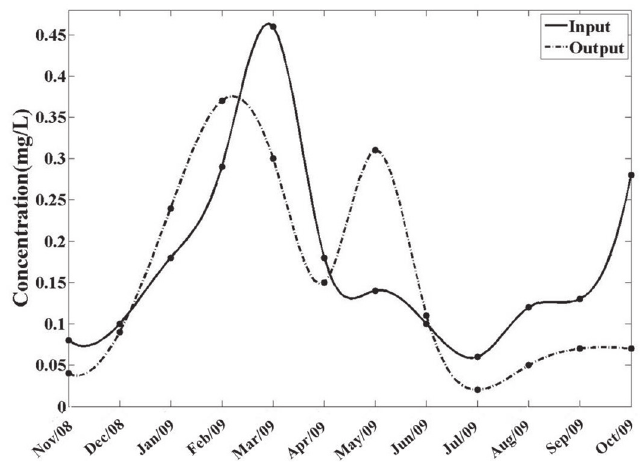
Figure 6 - Graphic representation of the concentration values for total phosphorus (mg/L) at the entrance and exit of reservoir